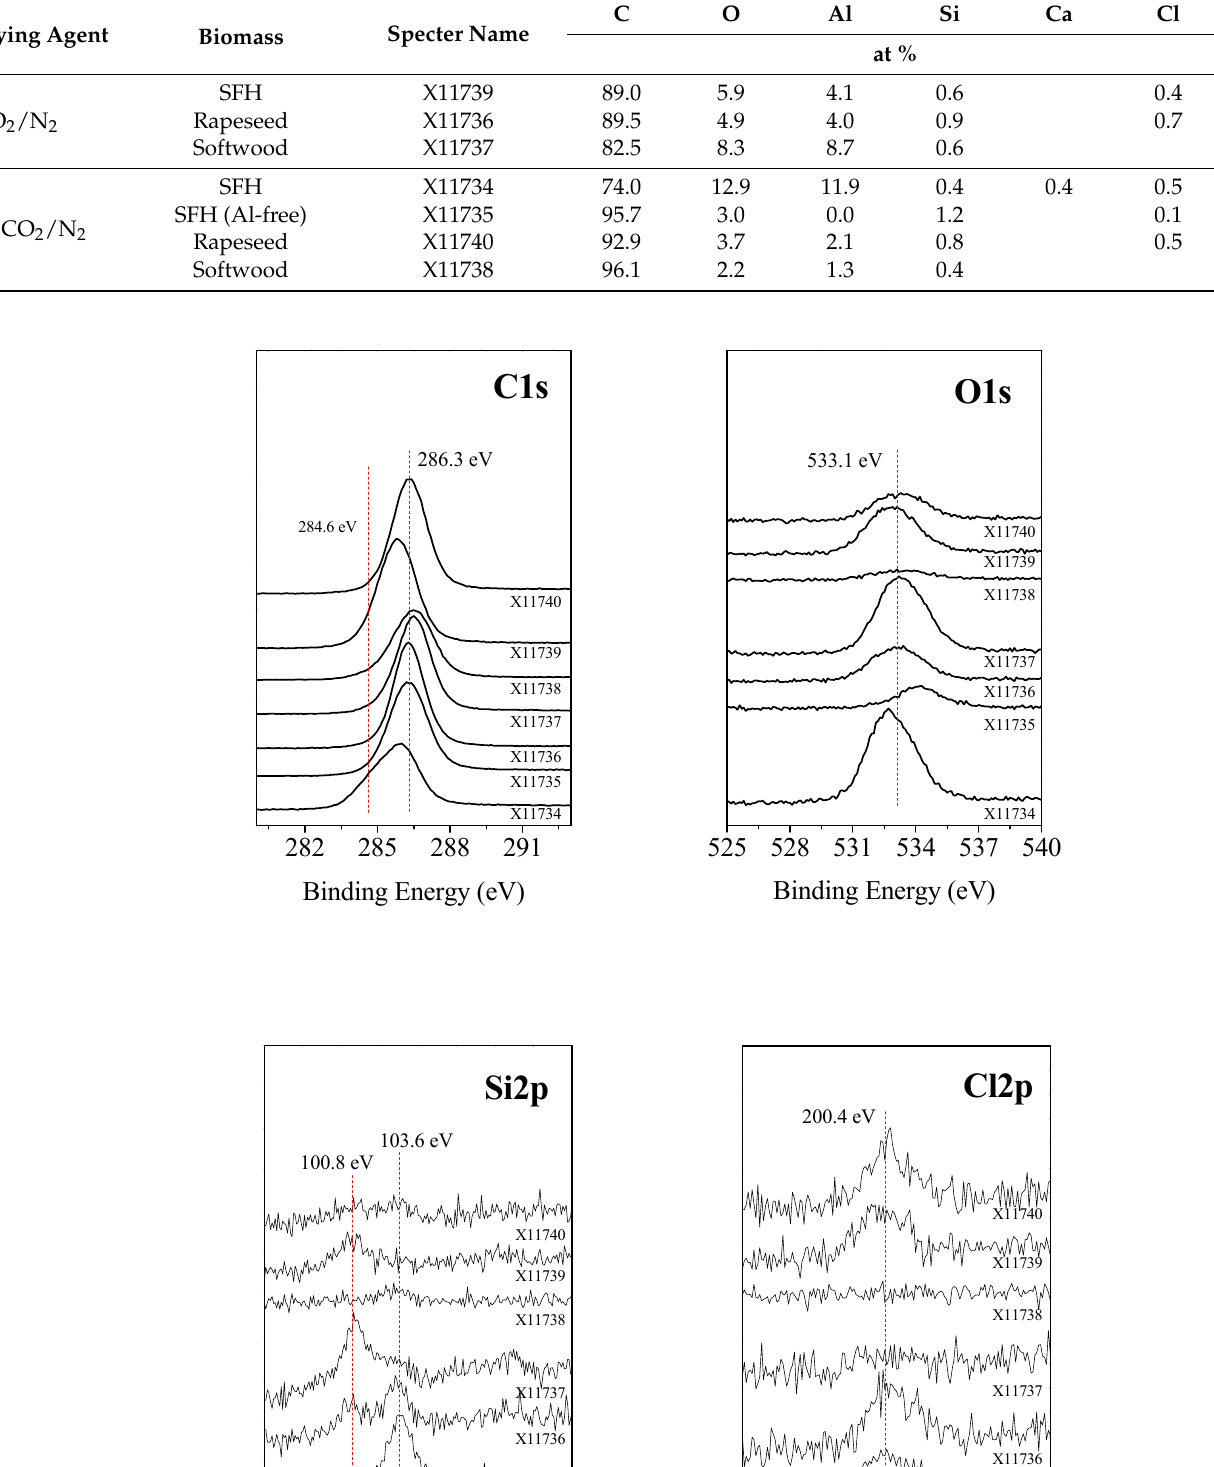
Table 4. Chemical composition of PM1 obtained through XPS analysis.